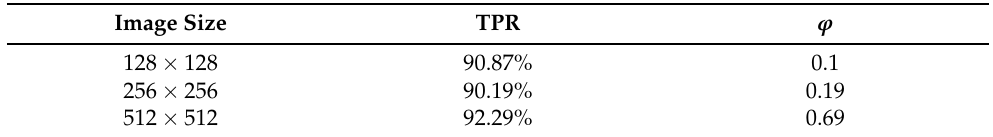
Table 1. Performance assessment of the proposed procedure in view of particle estimation task. TPR is the true positive ration depicted in (5), while ϕ is the average number of particles erroneously recognized (see (6)).